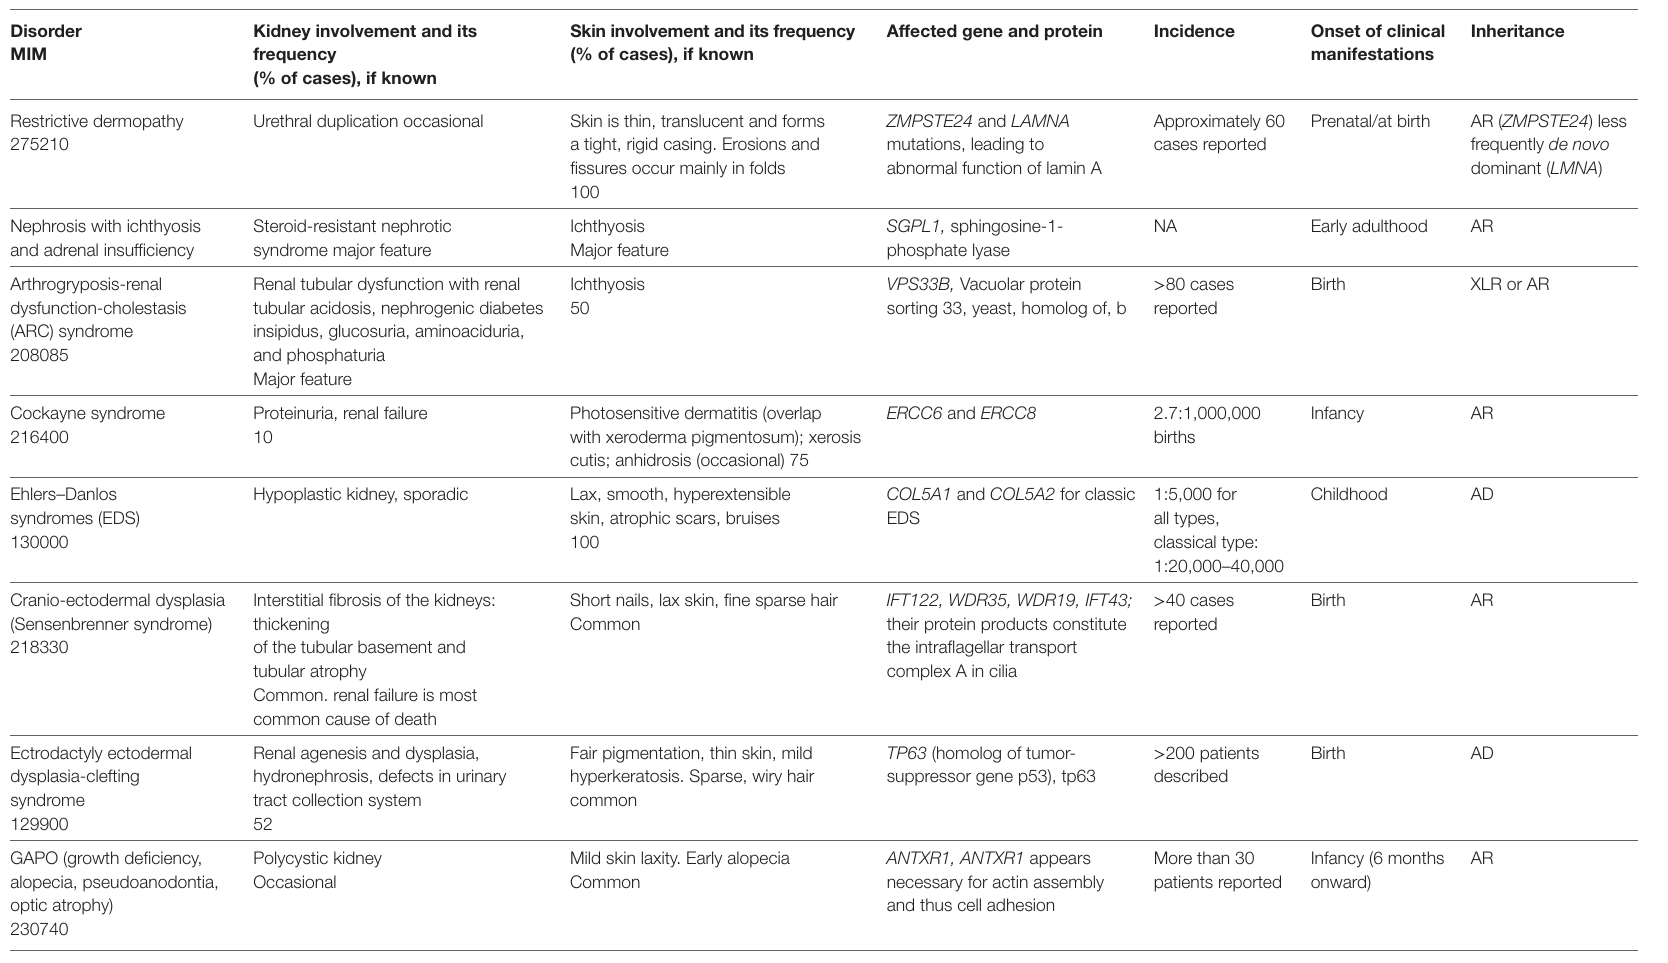
TABLe 1 | Genodermatoses with reno-urinary